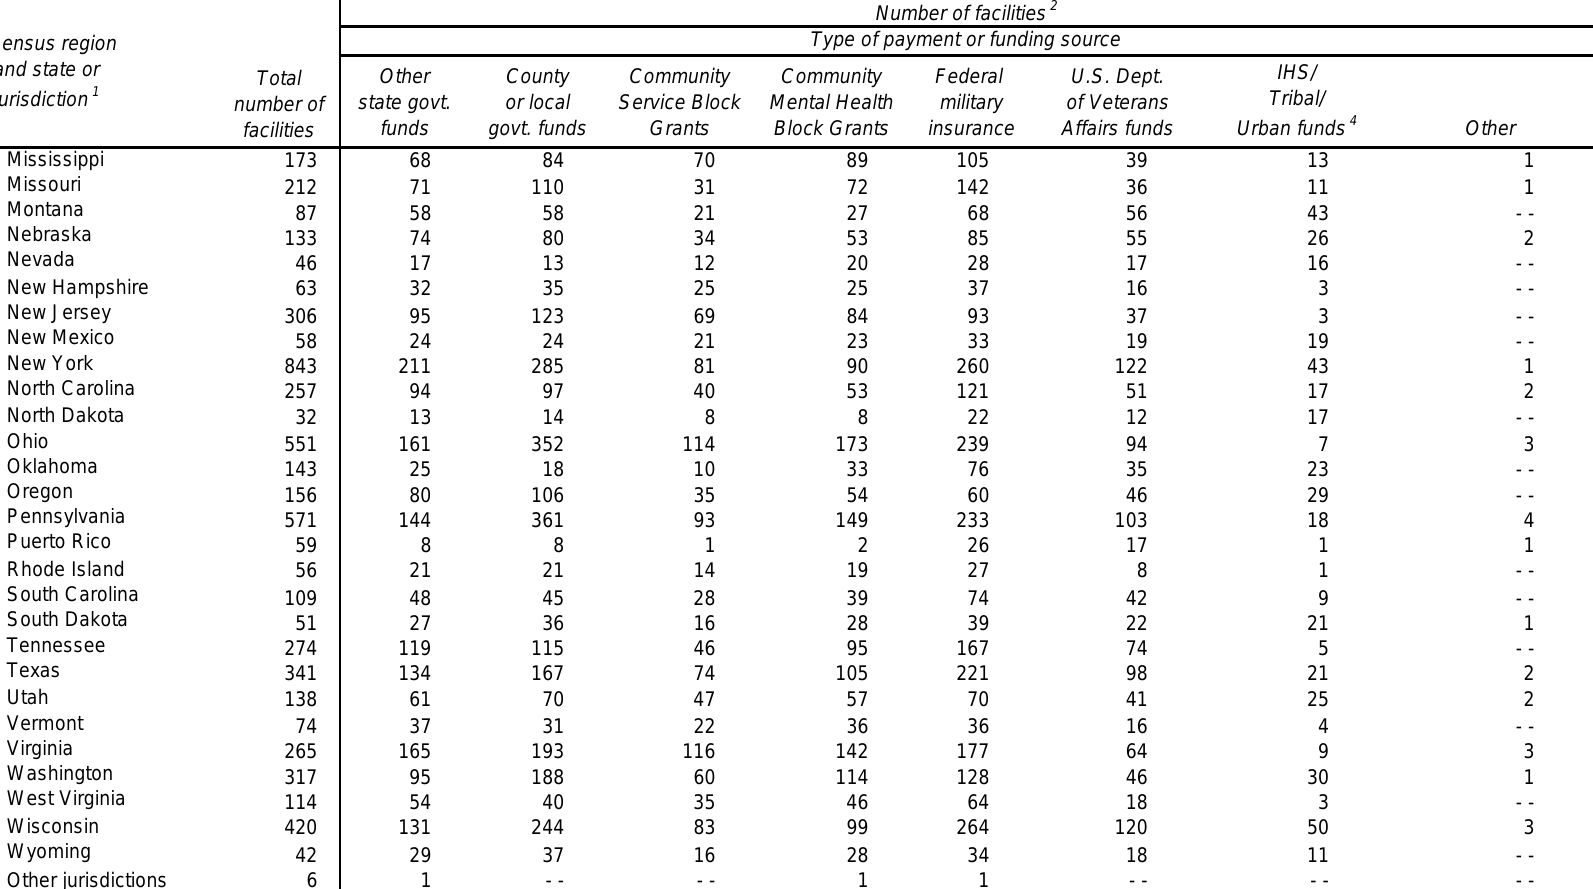
Table 3.13a. Mental health treatment facilities accepting a specific type of payment or funding source, by Census region and state or